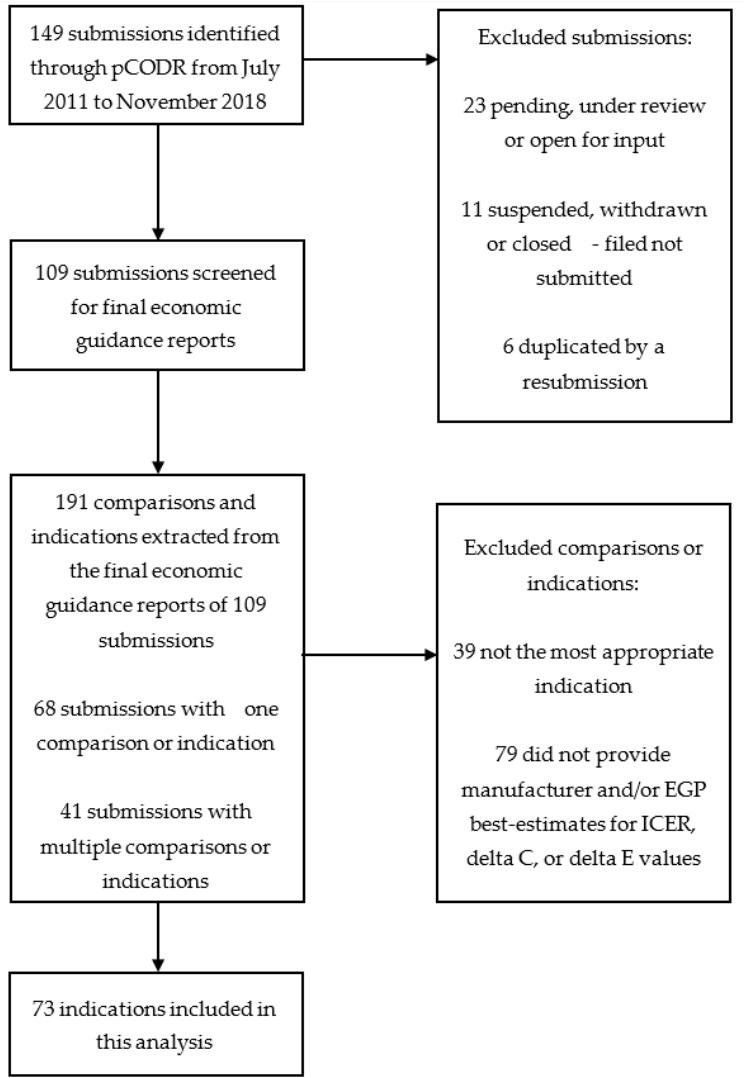
Figure 1. Selection of indications. For certain submissions, multiple indications were reported and only the most appropriate indications as per the pan-Canadian Oncology Drug Review (pCODR) Final Clinical Guidance Reports were included in these